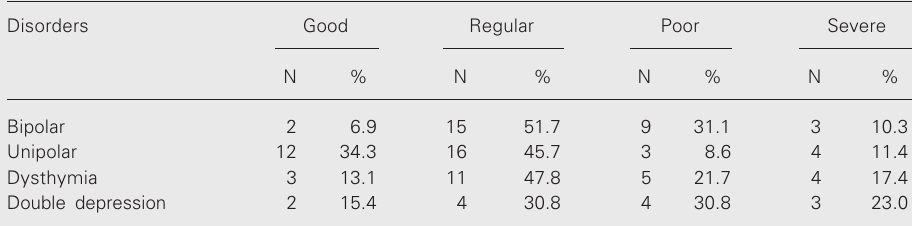
Table 2. Patient scores on the Global Assessment of Relational Functioning Scale. Disorders